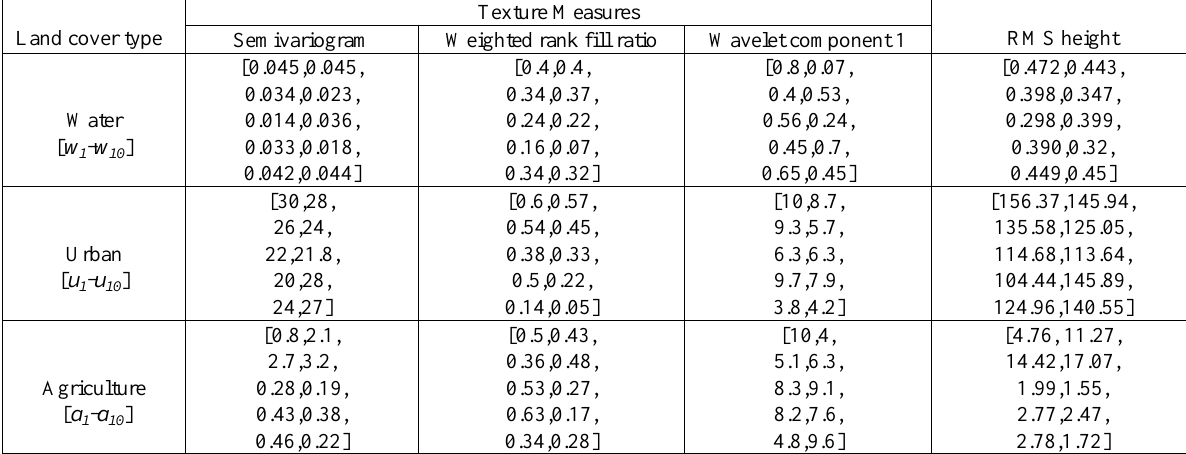
Table 2. RMS height calculated in real SAR image for water, urban and agriculture areas. (w 1 -w 10 represent 10 samples of water areas and corresponding texture measures with RMS height‘ s ’ are listed.